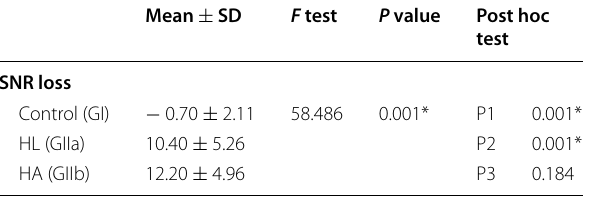
Table 2 ANOVA test for comparison of SNR loss of primary task (QuickSIN test) results in dual conditions between the control and study